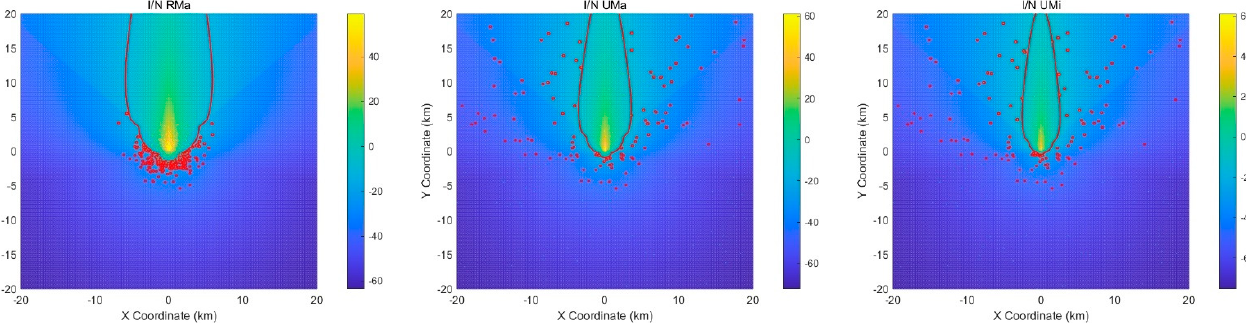
Figure 15. RMa, UMa, and UMi scenarios with ES antenna elevation angle of 5° for an 8 × 8 beamforming antenna array.